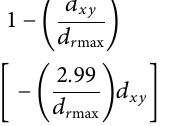
Frontiers in Earth Science |